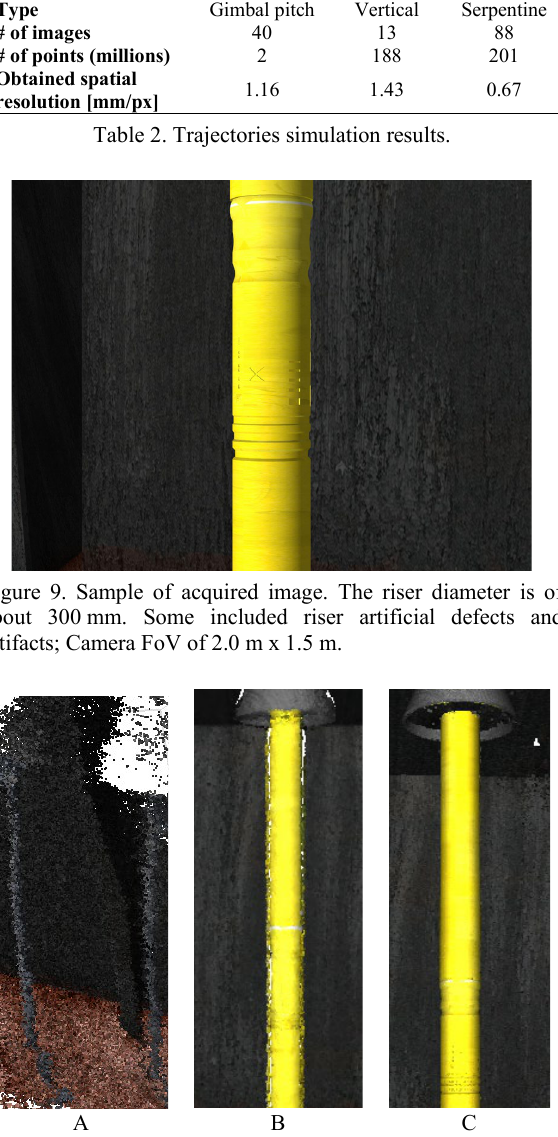
Figure 10. Photogrammetric textured 3D dense cloud for the three different trajectories. For “A” the software was unable to reconstruct the riser.